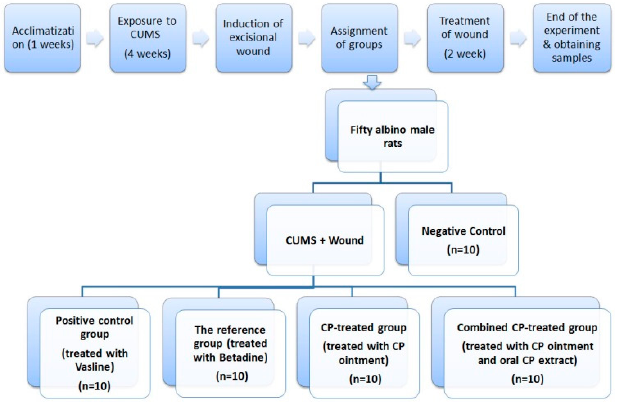
Figure 1. Design and grouping of the experiment. CP: Cucurbita pepo L.